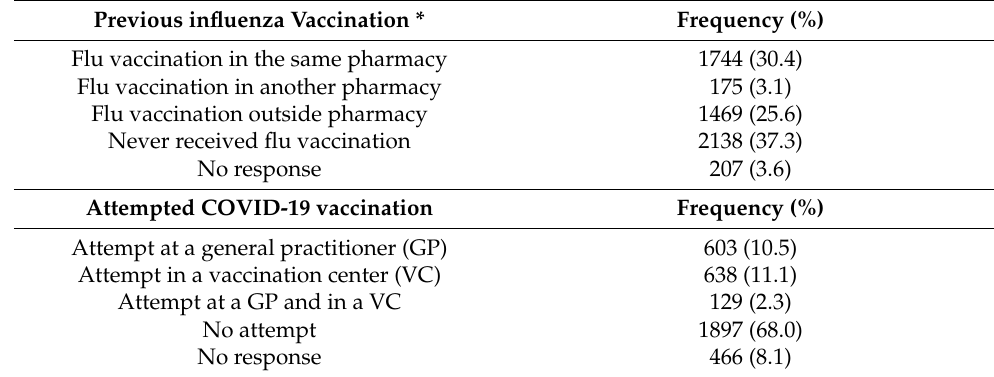
Table 2. Respondent characteristics concerning influenza vaccination history and COVID-19 vaccina- tion attempts.